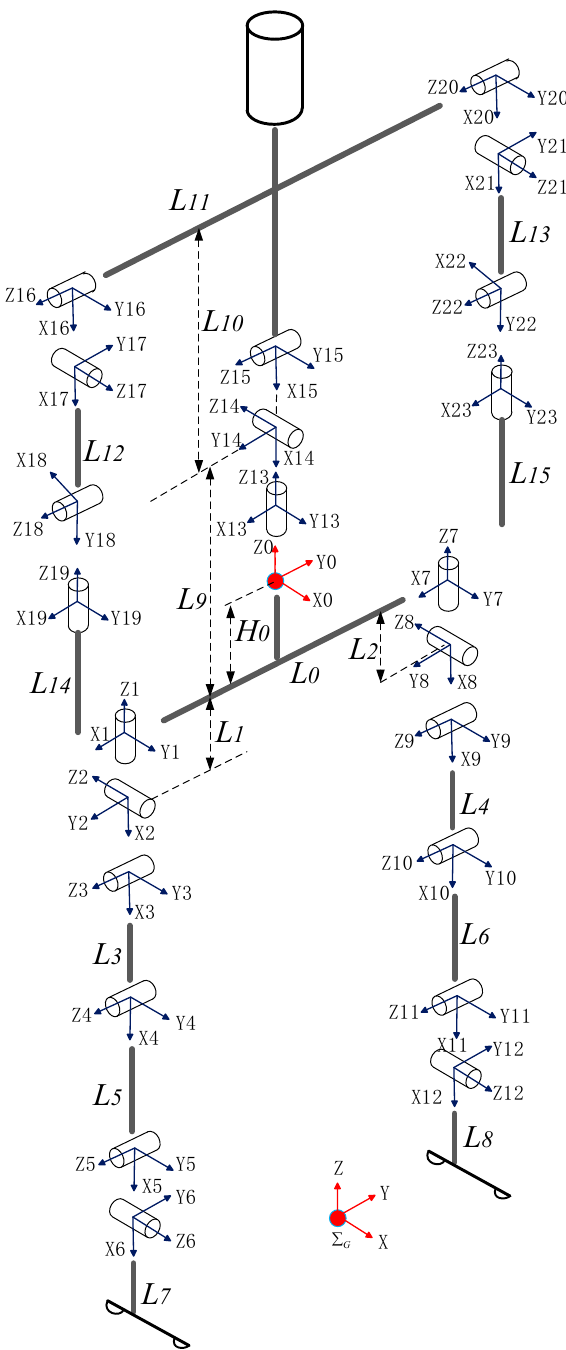
Figure 14. Kinematic modelling.